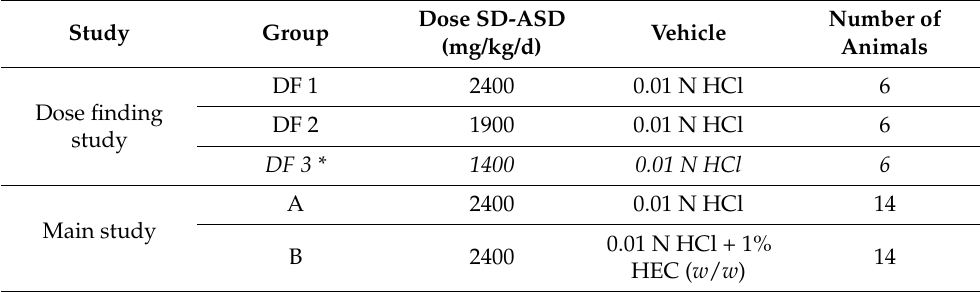
Table 2. Overview of dose finding study and main